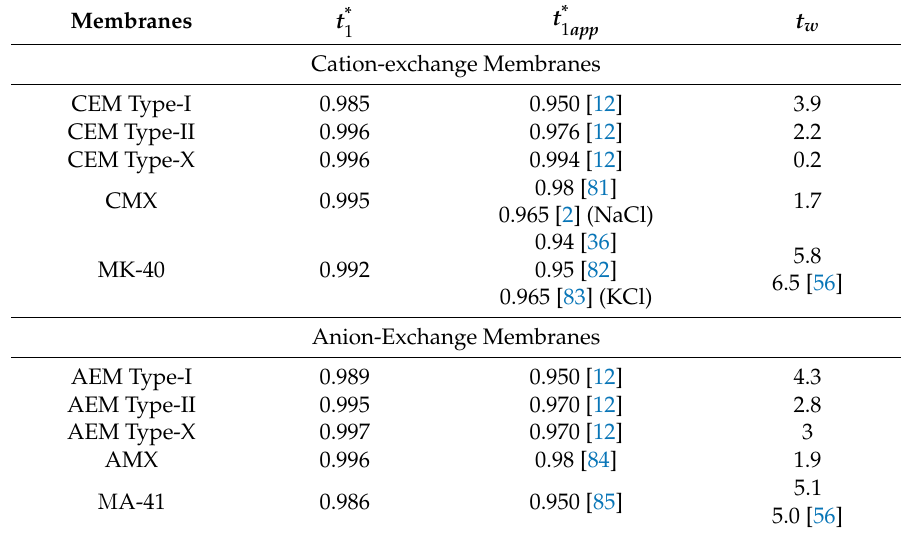
) and apparent ( t ∗ ) counterion transport numbers, as well as the 1 1 app